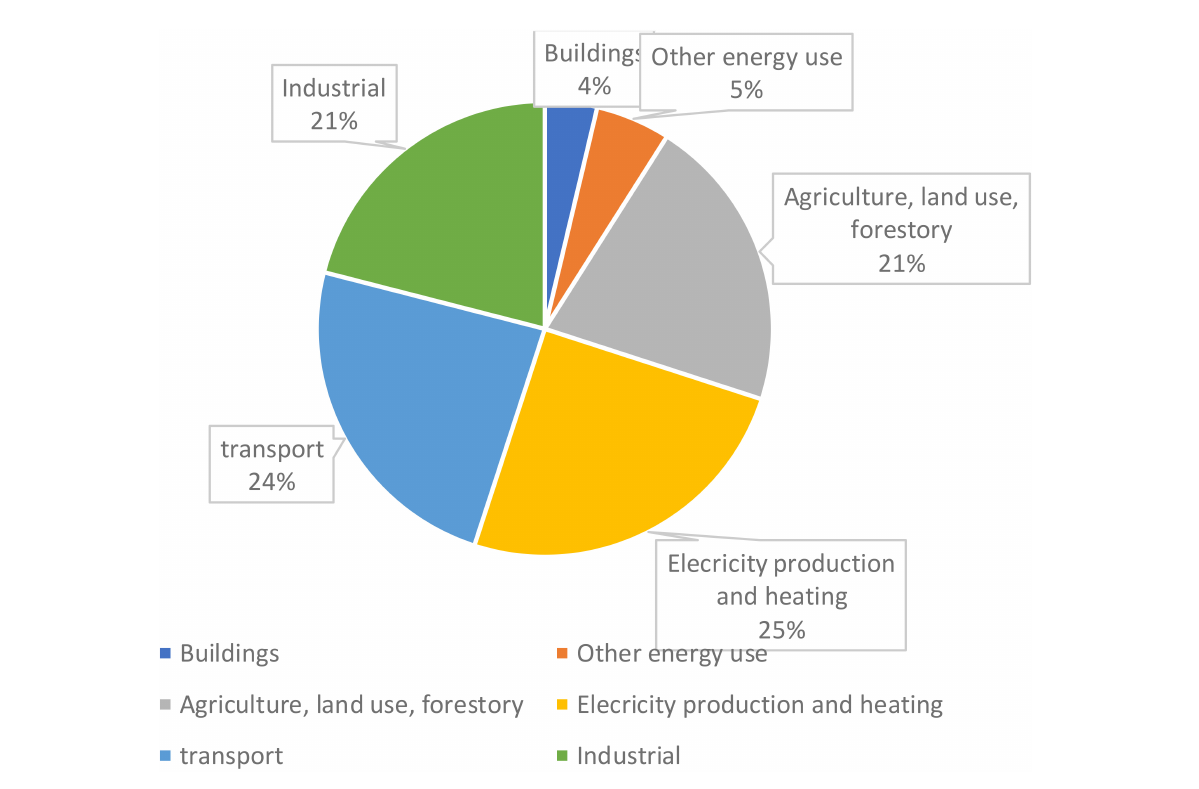
FIGURE1 Global sources of greenhouse gases by 2022. The Intergovernmental Panel on Climate Change